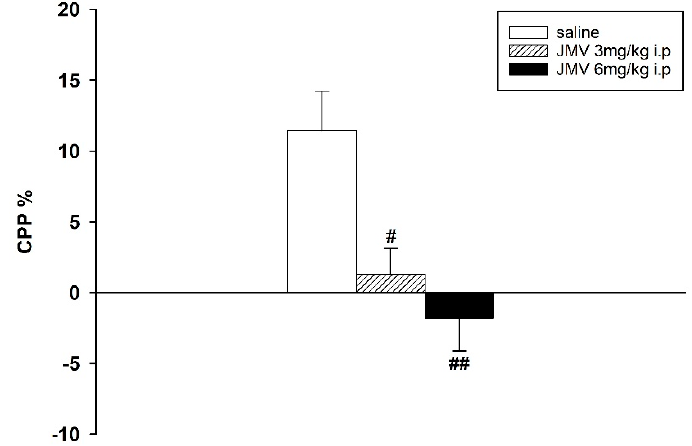
Figure 3. Effects of GHS-R1A antagonist on the conditioning procedure of 5 mg/kg methamphetamine-CPP in rats. During the eight days of conditioning, JMV2959 was administered repeatedly together with 5 mg/kg i.p. methamphetamine ( N = 8 in the saline and N = 9 in the JMV2959 groups; means ± SEM). Effects of JMV2959 pretreatments in comparison to the saline group are expressed as # p < 0.05, ## p < 0.01.